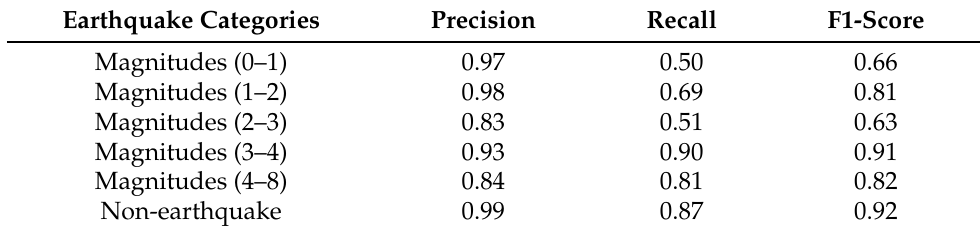
Table 3. Multi-label: Accuracy results for the proposed method in this